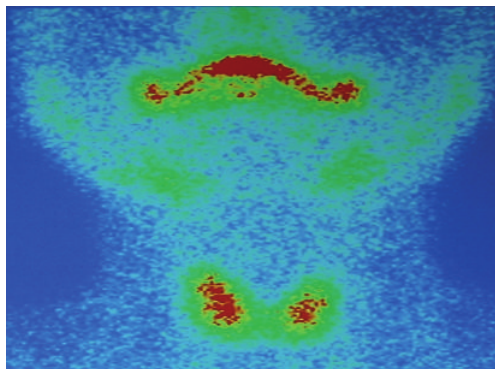
Figure 4: The scintiscan of the area with a Tc 99m showing no evidence of the existence of ectopic thyroid